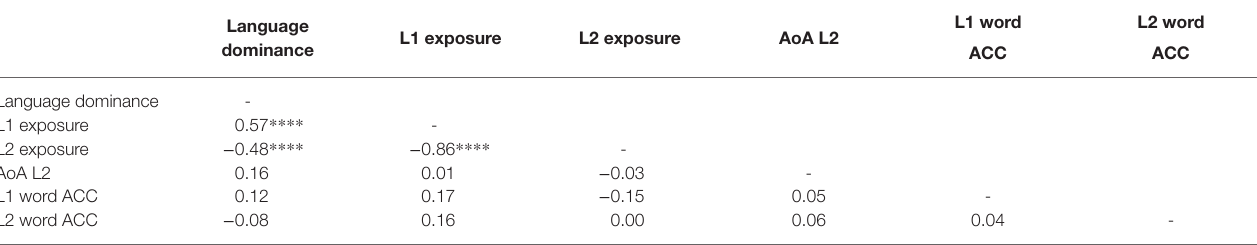
TABLE 7 | Bilinguals’ Pearson correlation analyses between language dominance, recent exposure, onset age of L2 acquisition (AoA L2), and language recognition performance in accuracy rates (ACC) in the lexical decision task. Language L1 exposure L2 exposure AoA L2 dominance